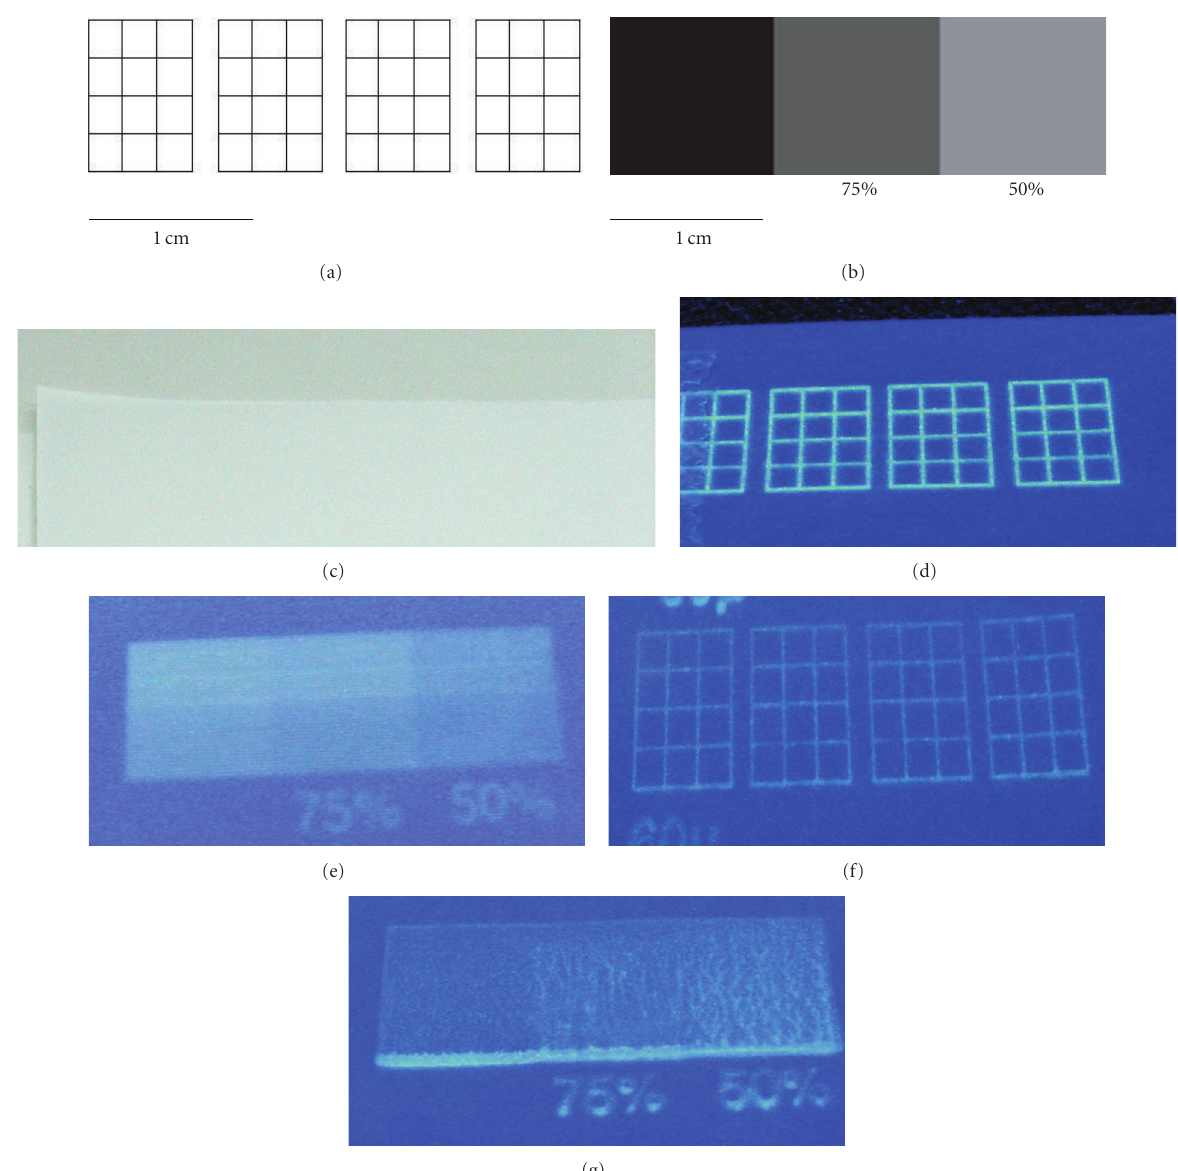
Figure 4: Printed patterns: grids of squares (a), full tones (b); printed tracing paper under room light (c); inkjet printed patterns under UV-light (d and e); flexography printed patterns under UV-light (f and